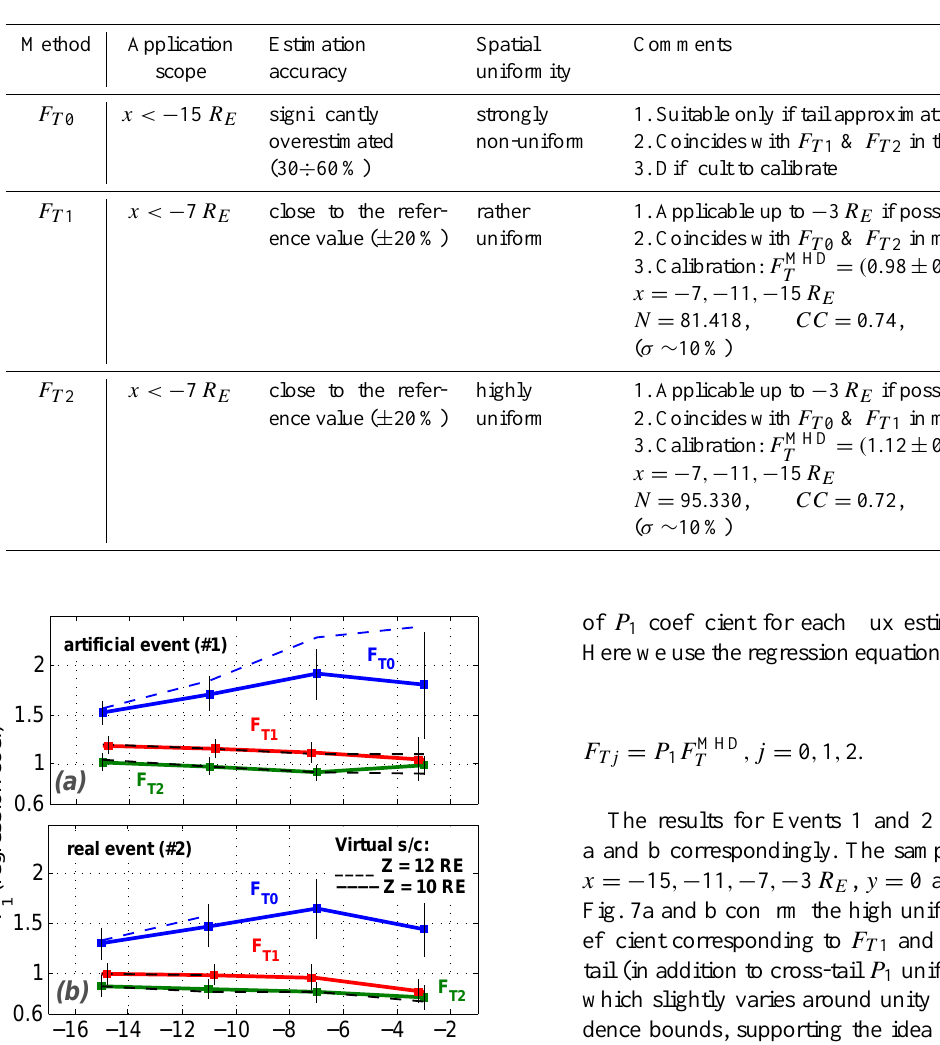
Table 1. Summary for methods application.